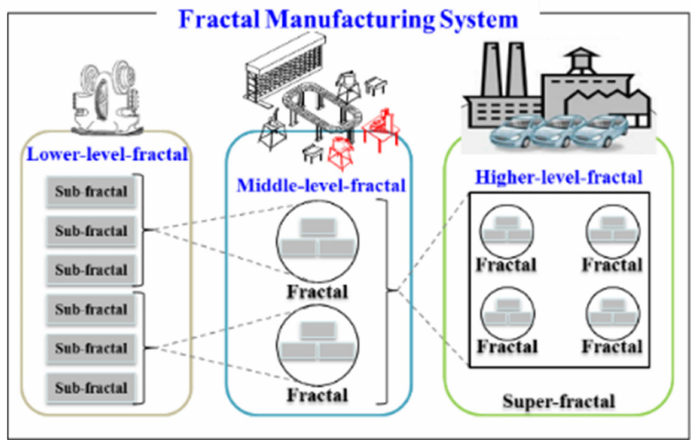
Figure 1. Conceptual model of FrMS.